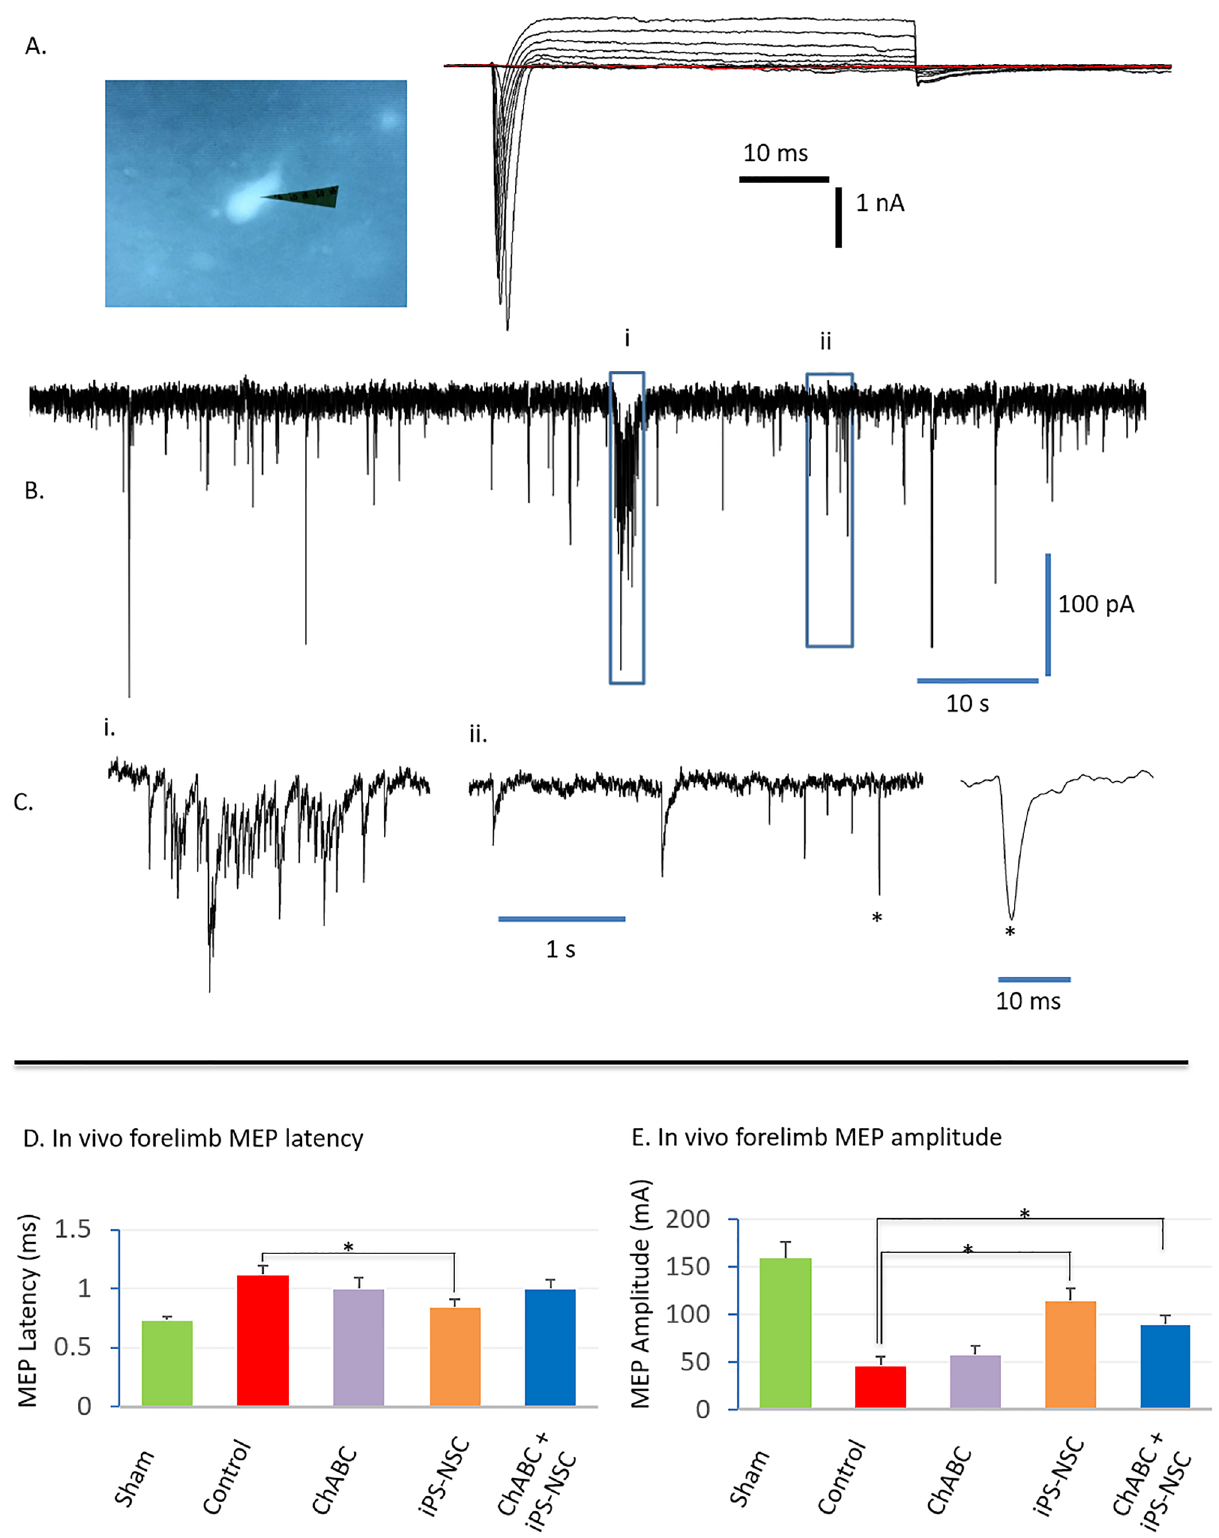
Fig 7. Patch-clamped transplanted GFP + cells in ex vivo cords demonstrate functional action potentials. (A) Electrical tracing demonstrating currents evoked by voltage pulses which containtransient inwardsodium currents and outwardpotassium currents.